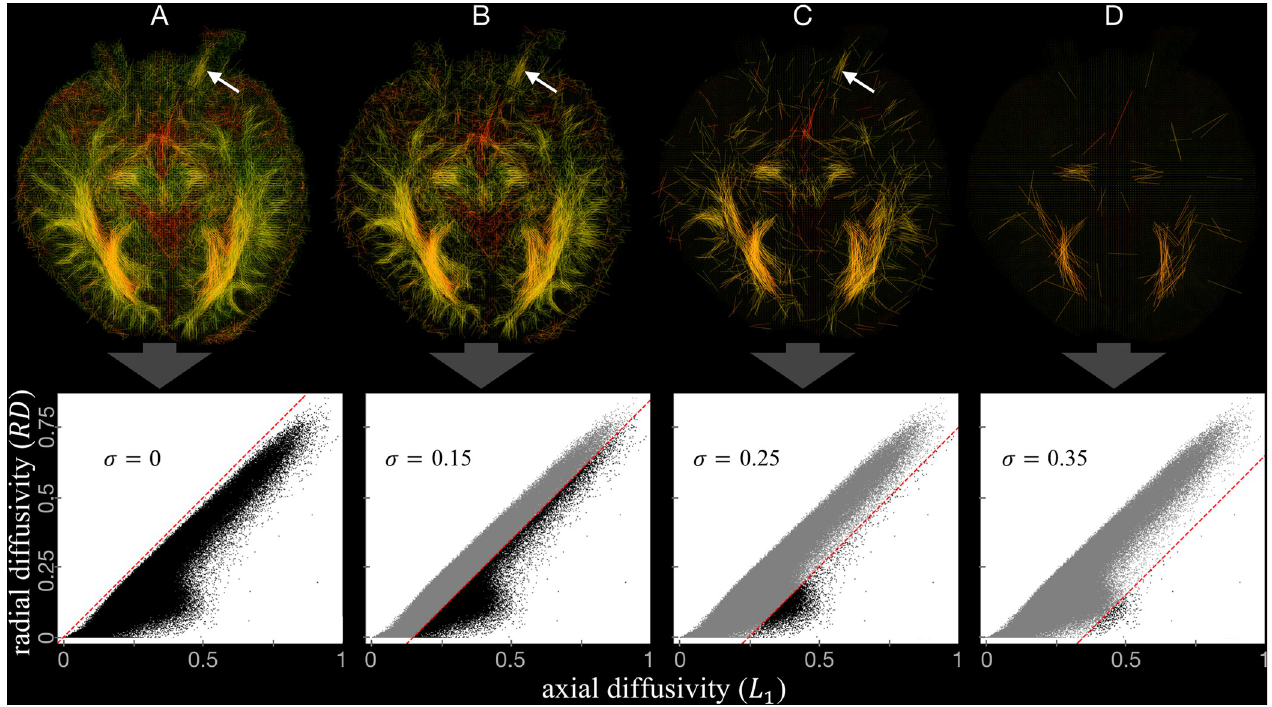
Fig 5. Images for male subject with right optic nerve neuropathy, generated for σ values equal to A) 0, B) 0.15, C) 0.25, and D) 0.35. Density plots in the bottom panels show all voxels in the datasets used for visualization (black dots) and voxels omitted according to condition (7) (grey dots). The dots are obtained from all voxels in the selected layers. The red dashed lines correspond to the condition L 1 certain value of σ is exceeded (D). Orientation convention: Radiological.